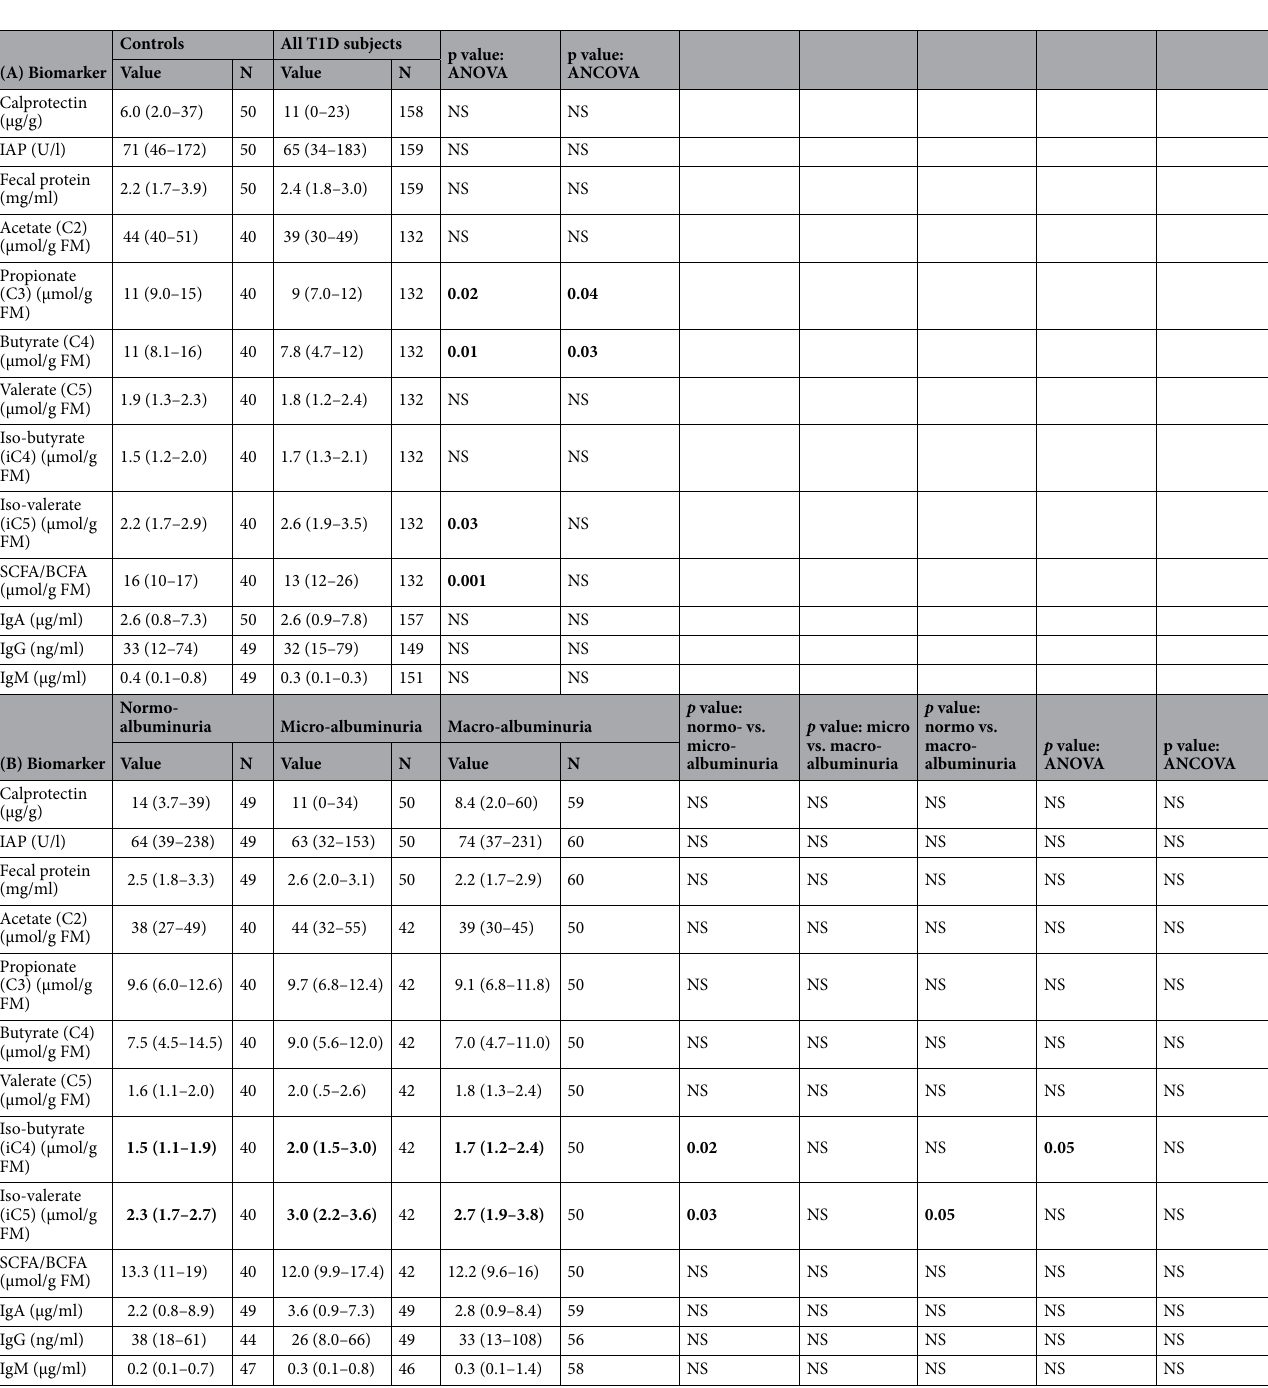
Table 2. Fecal biomarkers in (A) subjects with T1D and controls and (B) per historical albuminuria categories (normo-, micro- and macroalbuminuria). Data is shown as median (interquartile range). Log 10 -transformed values were used for all biomarkers. SCFA the sum of short chain fatty acids C2, C3, C4 and C5, BCFA the sum of branched short chain fatty acids iC4 and iC5, IAP intestinal alkaline phosphatase, Ig immunoglobulin, FM fecal mass. Significant differences between groups are shown in bold. p values were calculated by unpaired Students’ t test for group-wise differences (Table b), ANOVA and ANCOVA (ANCOVA covariates were age, sex, 24-h systolic blood pressure and